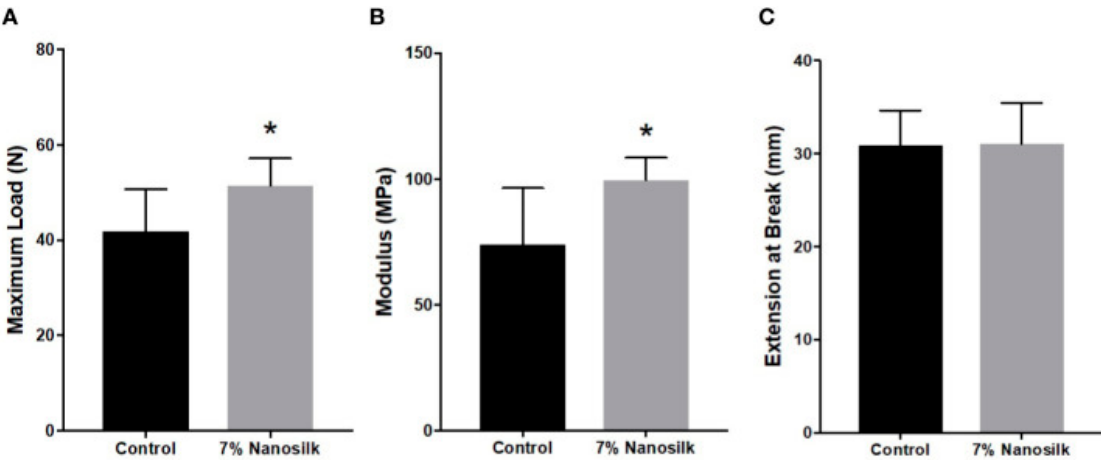
Figure 1. Mechanical strength of samples treated with 7% nanosilk or controls: ( A ) maximum load, ( B ) modulus, and ( C ) elasticity. Statistical significance ( p < 0.05) is indicated by *. Standard acknowl-